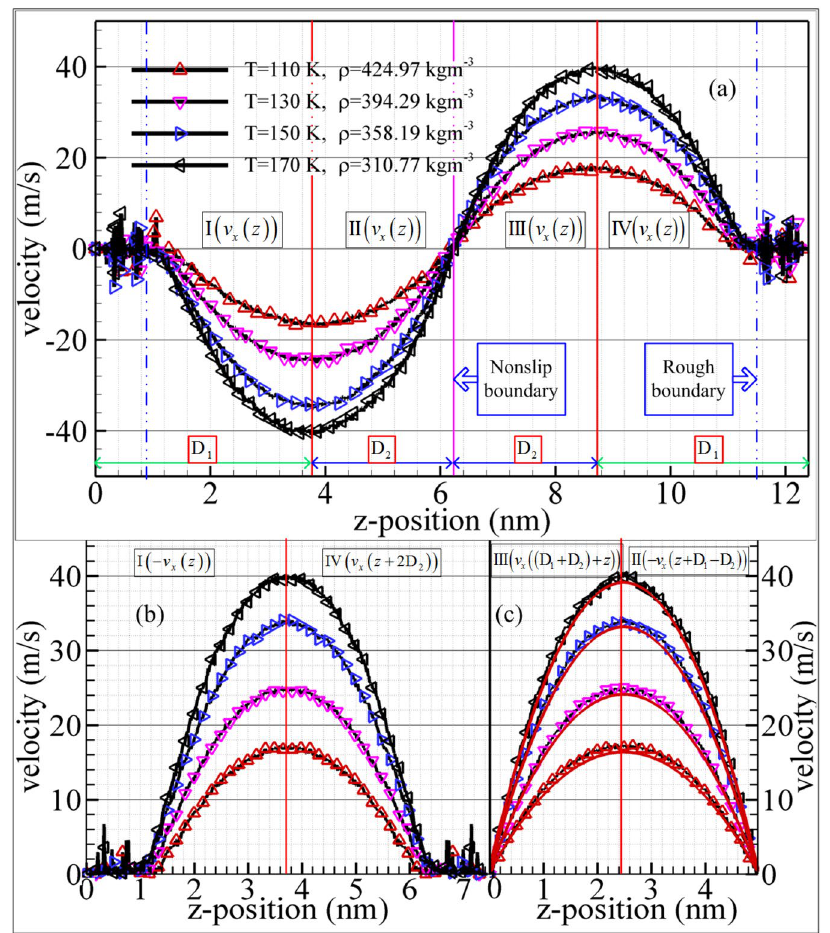
Figure 6. The velocity profiles from mixture boundary Poiseuille flow model by NEMSMD simulations. The black solid curves are guide. And red curve lines denote the analytical